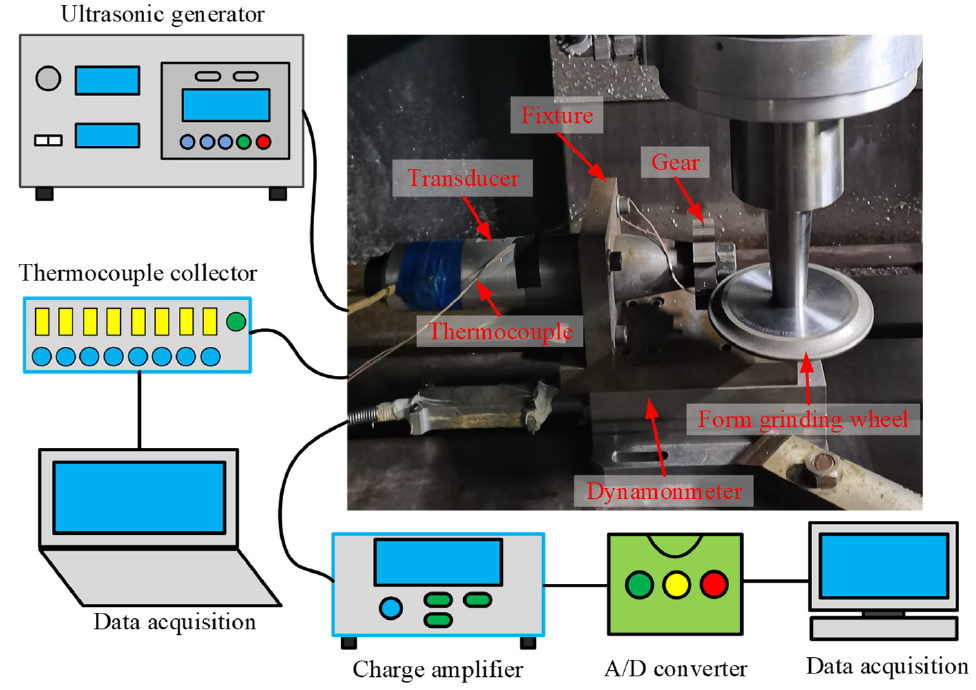
Figure 1. Experiment setup.